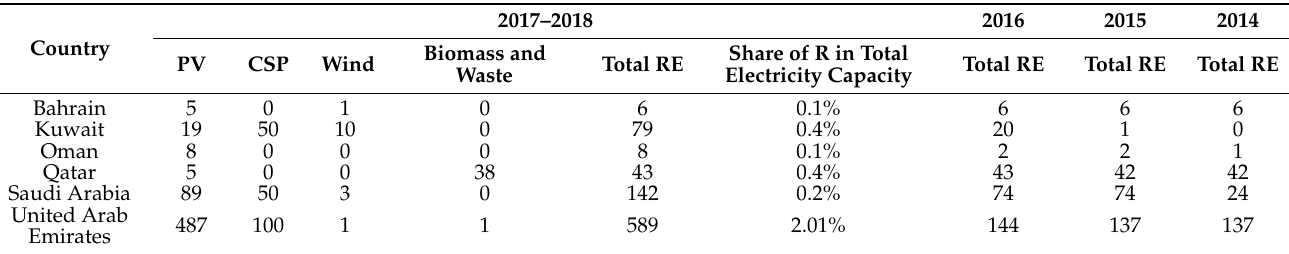
Table 1. Renewable energy capacity in the GCC countries [33].